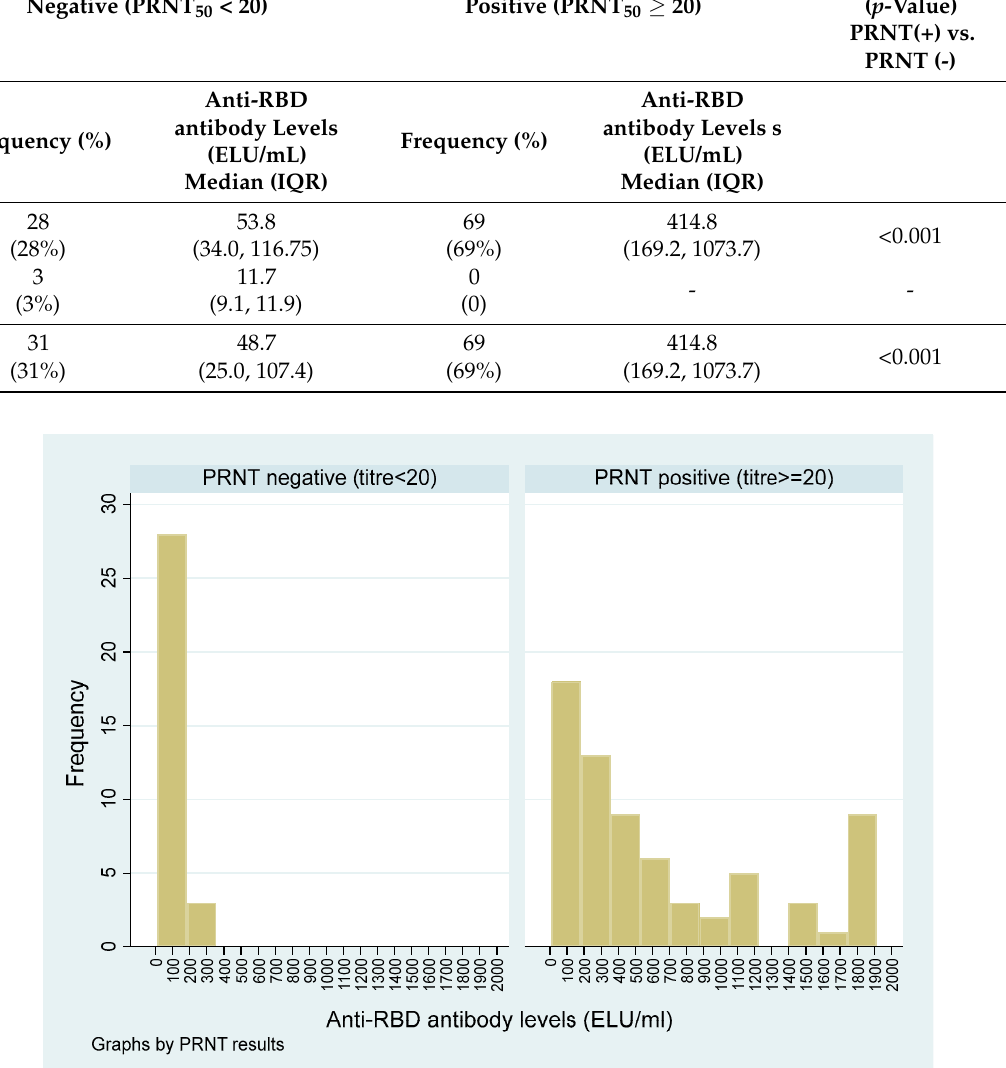
Figure 5. Histogram showing anti-RBD antibodies (ELU/mL) among the participants with respect to PRNT 50 < 20 and PRNT 50 ≥